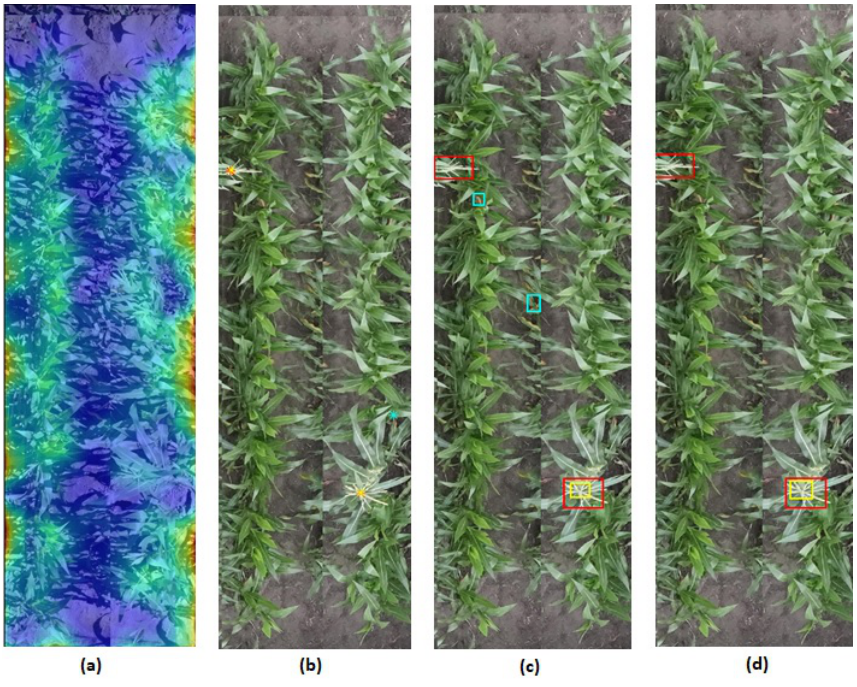
Figure 17. Results of Test Subset 11 (Ng: Red, TP: Yellow, FP: Cyan). ( a ) TasselNetv2+. ( b ) CenterNet. ( c ) TSD. ( d ) DetectoRS.